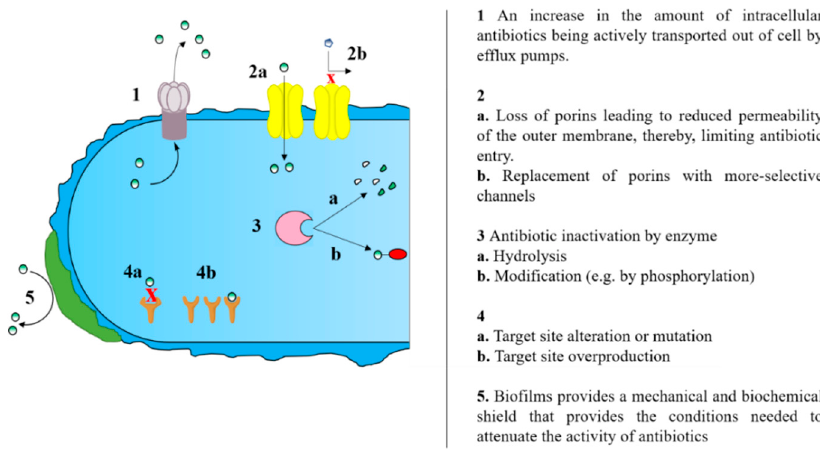
Figure 1. Schematic diagram of the different mechanisms facilitating acquired resistance.